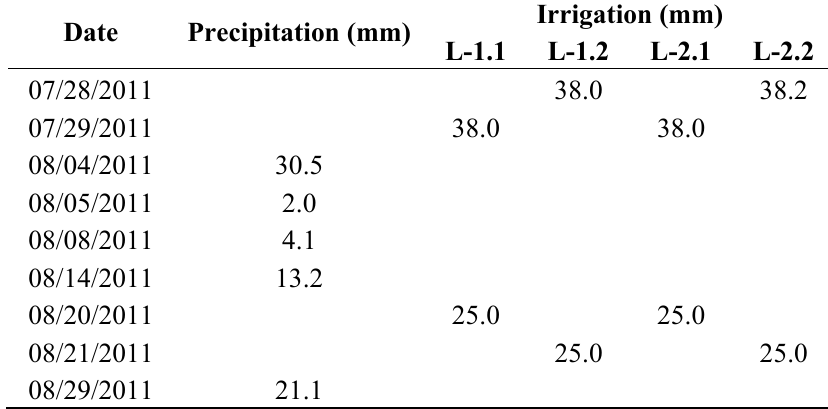
the beginning and one week after the end of the study